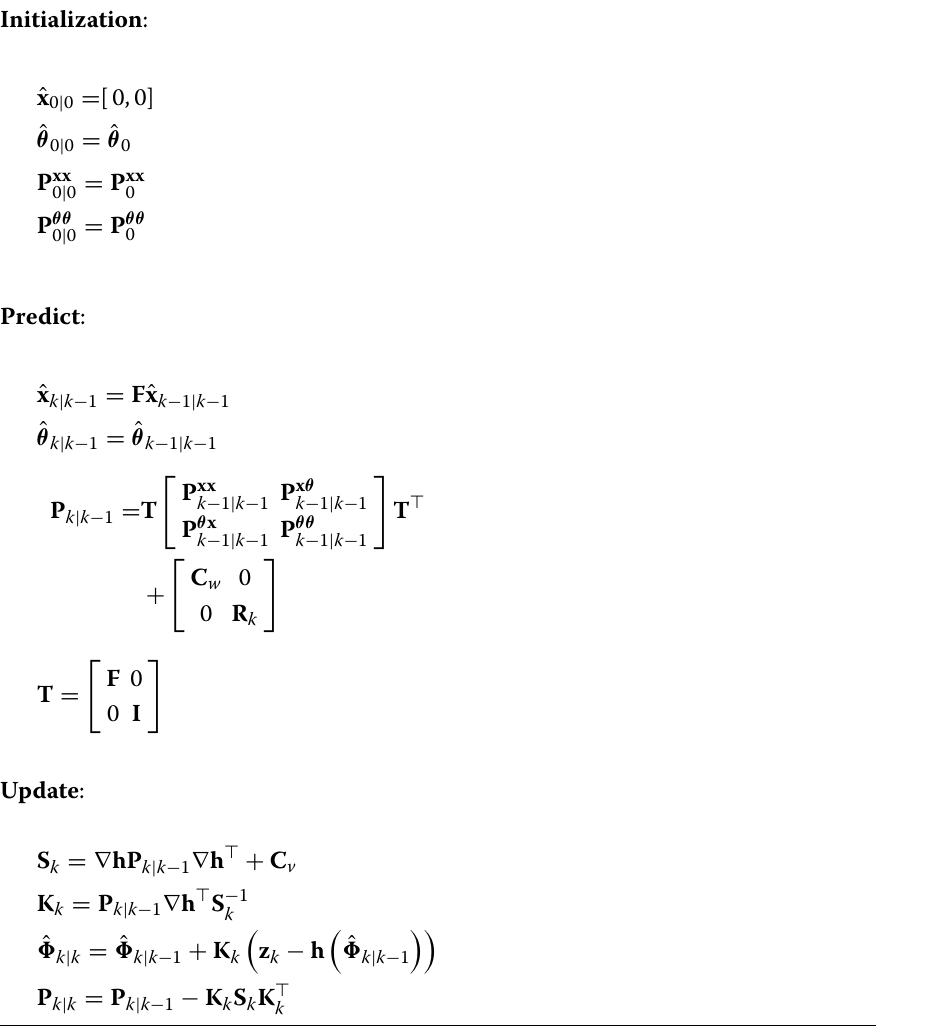
Algorithm 1 EKF